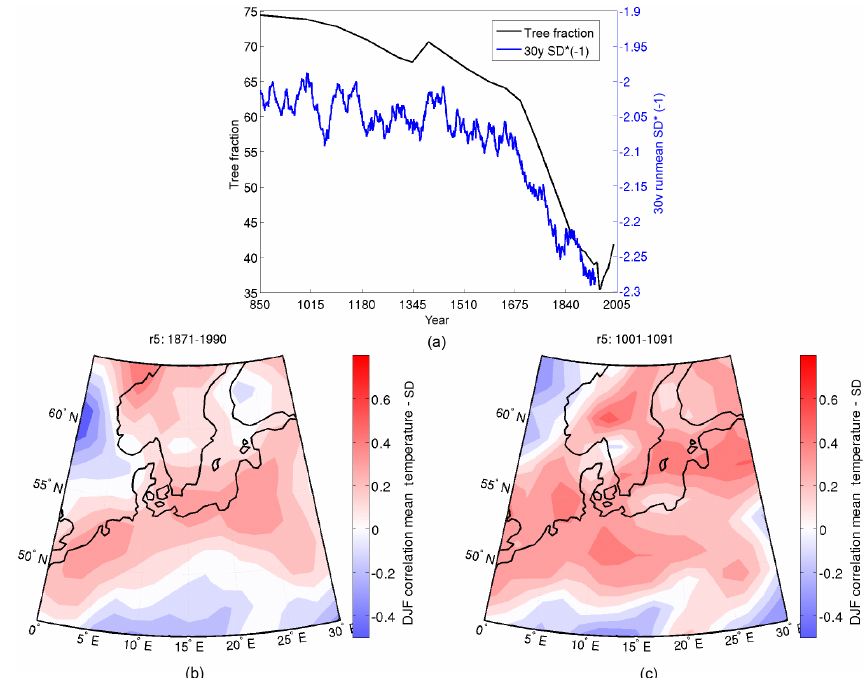
Figure 11. (a) tree fraction after Pongratz et al. (2008) (black) averaged over the investigation area. ECHAM6 30-year running mean SD of wind speed (multiplied by − 1) (blue). (b) Correlation between field mean temperature and SD for 1871–1990 with a 5-year running mean computation (c) correlation between field mean temperature and SD for 1001–1091 with a 5-year running mean